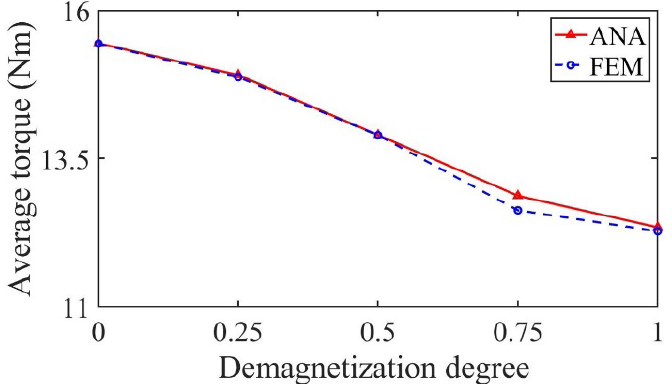
Figure 24. Variation in the average torque with demagnetization degree.